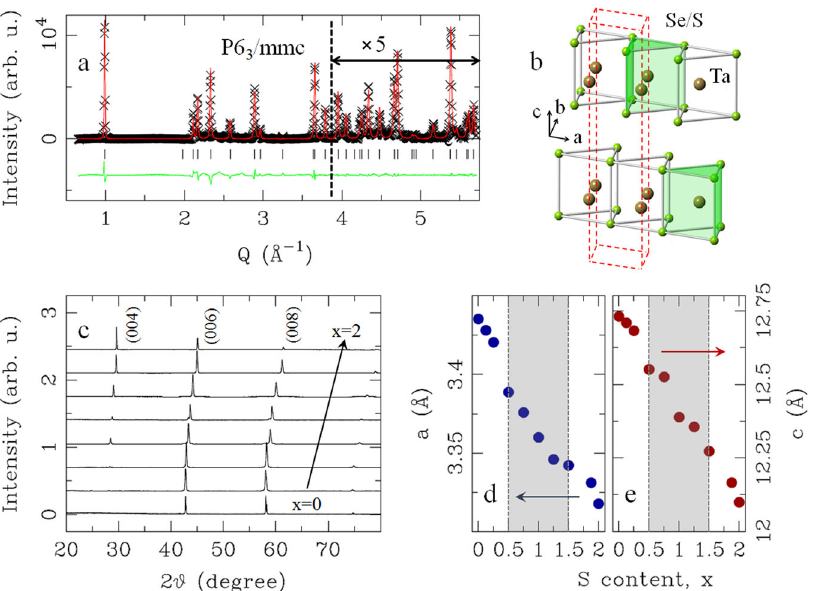
Fig. 1 Crystal structure aspects of 2H-TaSe 2 − x S x (0 ≤ × ≤ 2) a Powder XRD pattern for 2H-TaSe 2 at 300 K, shown as scattering intensity vs. momentum transfer Q , indexed within P63/mmc space group. Crosses are data, solid red line is the model, green solid line is the difference (offset for clarity), and vertical ticks mark are the re fl ections. b Structural motif of the P63/mmc model. Red dashed box depicts the unit cell. c Single crystal XRD patterns at the room temperature. Patterns are offset for clarity. d , e Room temperature evolution of a and c lattice parameters, respectively, as obtained from powder diffraction data. Shaded is the range where CDW cannot be detected in resistivity